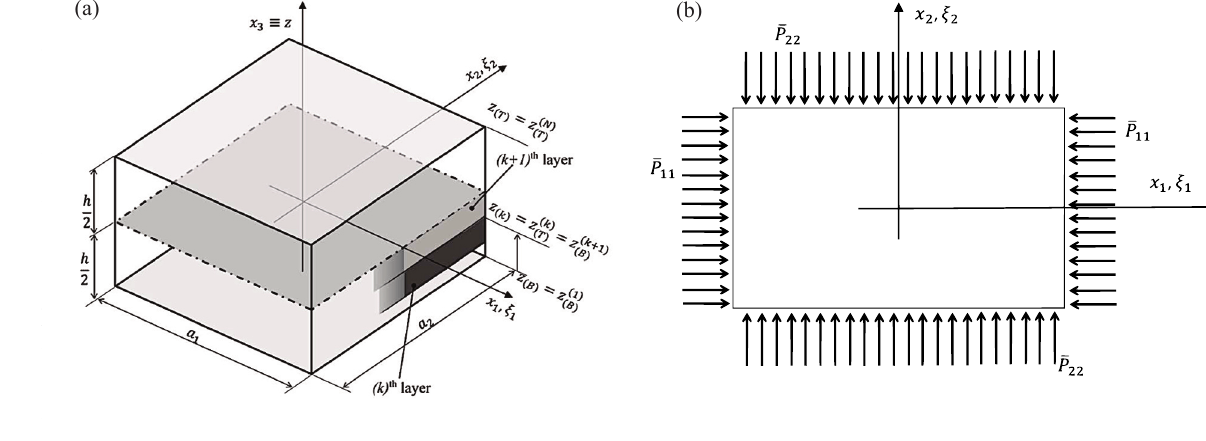
Fig. 1. General plate notation: (a) plate geometry and coordinate system and layer numbering, (b) in-plane loads